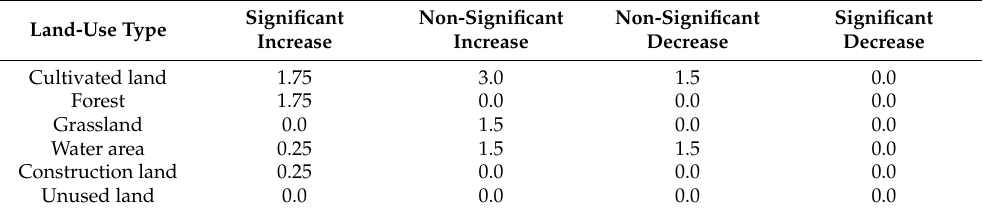
Table 6. Betweenness centrality of land-use types in regions with different vegetation-cover change trends.